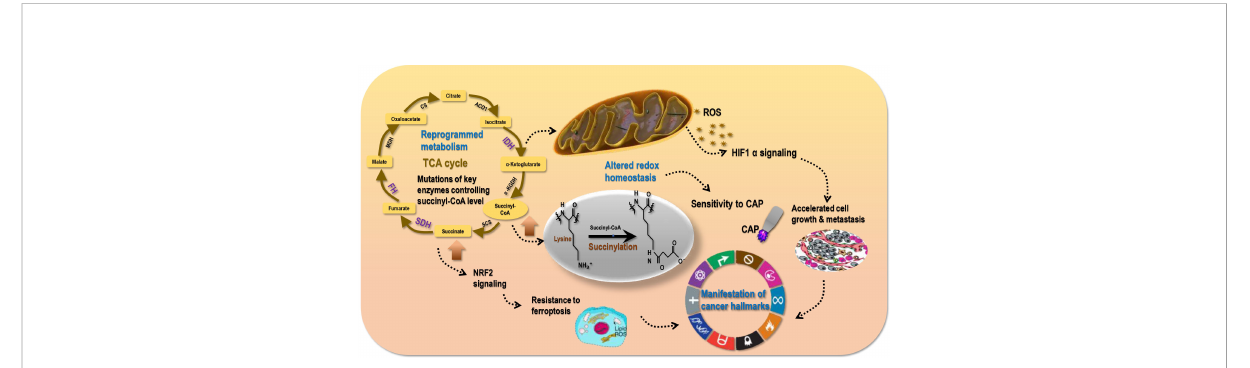
FIGURE 5 Succinylation re fl ects cell redox status that sensitizes tumors to redox modulation tools. Metabolism reprogramming in cancer cells as a result of, e.g., IDH, SDH, FH mutations may lead to elevated levels of succinyl-CoA and succinate. High succinyl-CoA leads to hyper-succinylation; thus, succinylation is a re fl ection of reprogrammed metabolism. High level of succinate results in activated NRF2 signaling that is associated with enhanced anti-oxidant ability of cancer cells (cancer stemness) and resistance of transformed cells to ferroptosis. In addition, abnormal metabolism is associated with elevated mitochondria ROS generation that is accompanied with activated HIF1 a signaling and a hypoxic environment favoring cell proliferation and metastasis. These collectively result in the manifestation of cancer hallmarks and altered redox homeostasis in malignant cells. Re-established redox homeostasis in cancer cells differs from that in their healthy peers, leading to the differential sensitivities of tumor and normal cells to redox perturbation tools such as cold atmospheric plasma